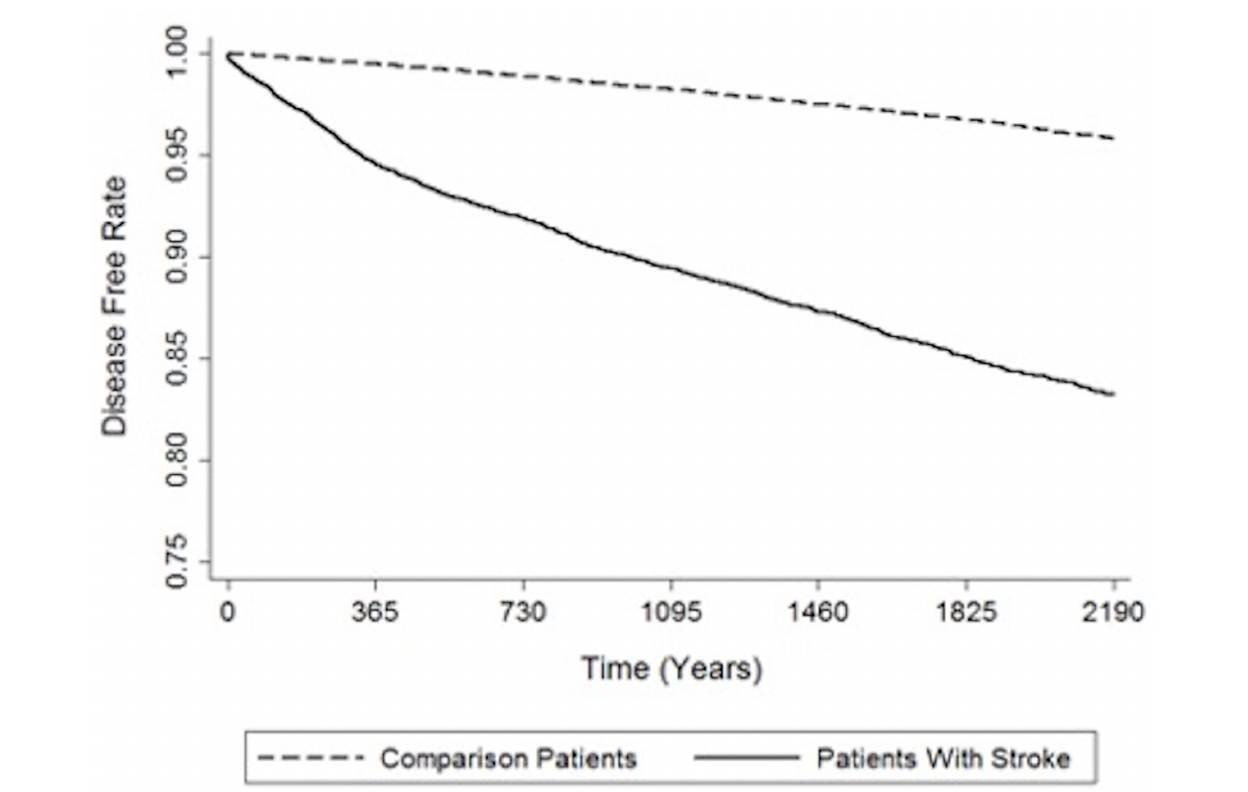
FIGURE 2 | Indicates the disease-free survival curves determined using the Kaplan–Meier log rank analysis.